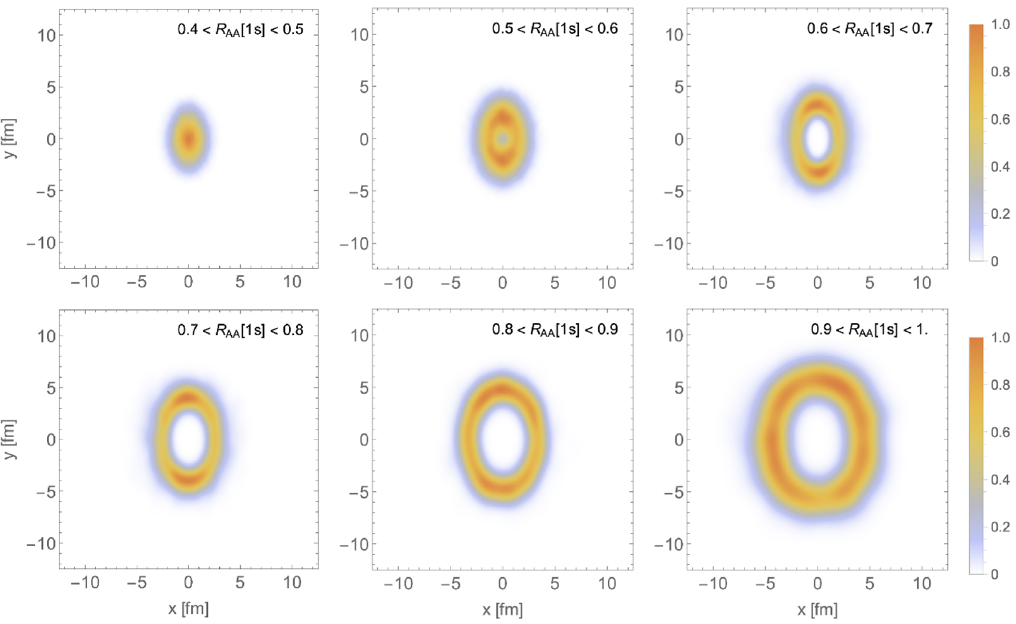
Figure 4 . Visualization of the initial probability distribution function for the starting positions of Υ(1 s ) . Panels show distribution for states experiencing a given R in 10% intervals, e.g. AA 0 . 4 < R 0 . 5 . For this visualization, we selected all states with 0 < p 40 GeV. Coloring AA < T < encodes the normalized probability in each R AA